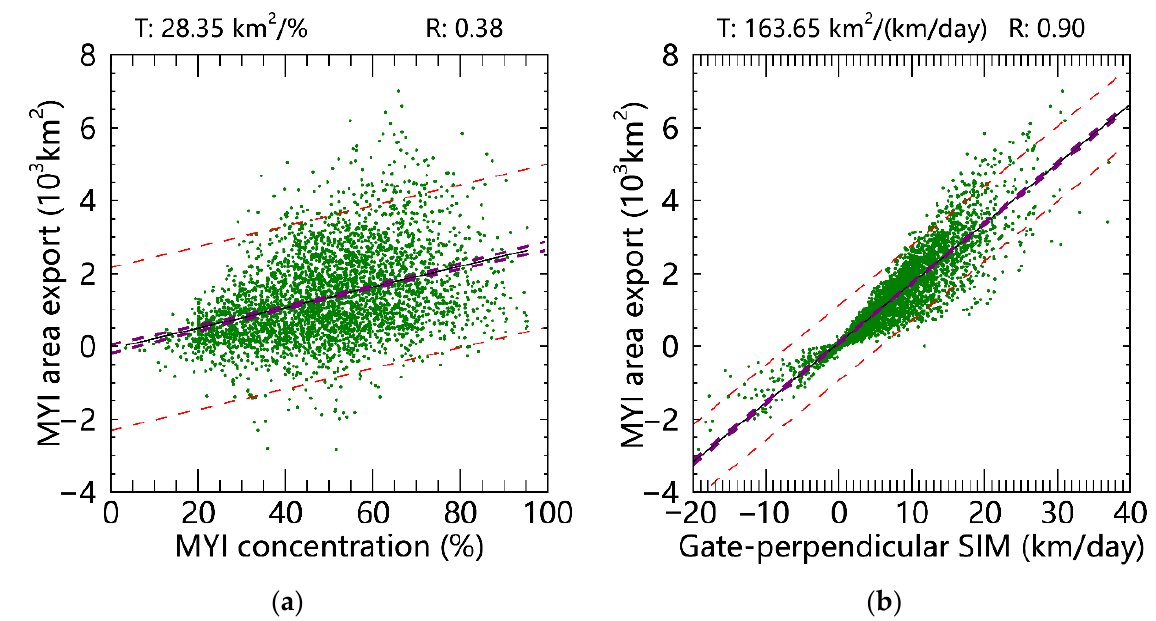
Figure 6. Scatter plots of weekly observations between ( a ) MYI area export through the FS and MYI concentration across the strait and between ( b ) MYI area export and gate-perpendicular SIM for the 2002/03 – 2019/20 period except for 2011/12. The black line represents the linear regression between two variables. Red dashed lines represent 95% deviations, denoting the difference between original data and predicted data. The purple dashed lines indicate 95% confidence bounds of the regression. Above each panel, T is the slope of regression, R is the correlation coefficient. Trends and correlations are all significant at the 99% confidence level.